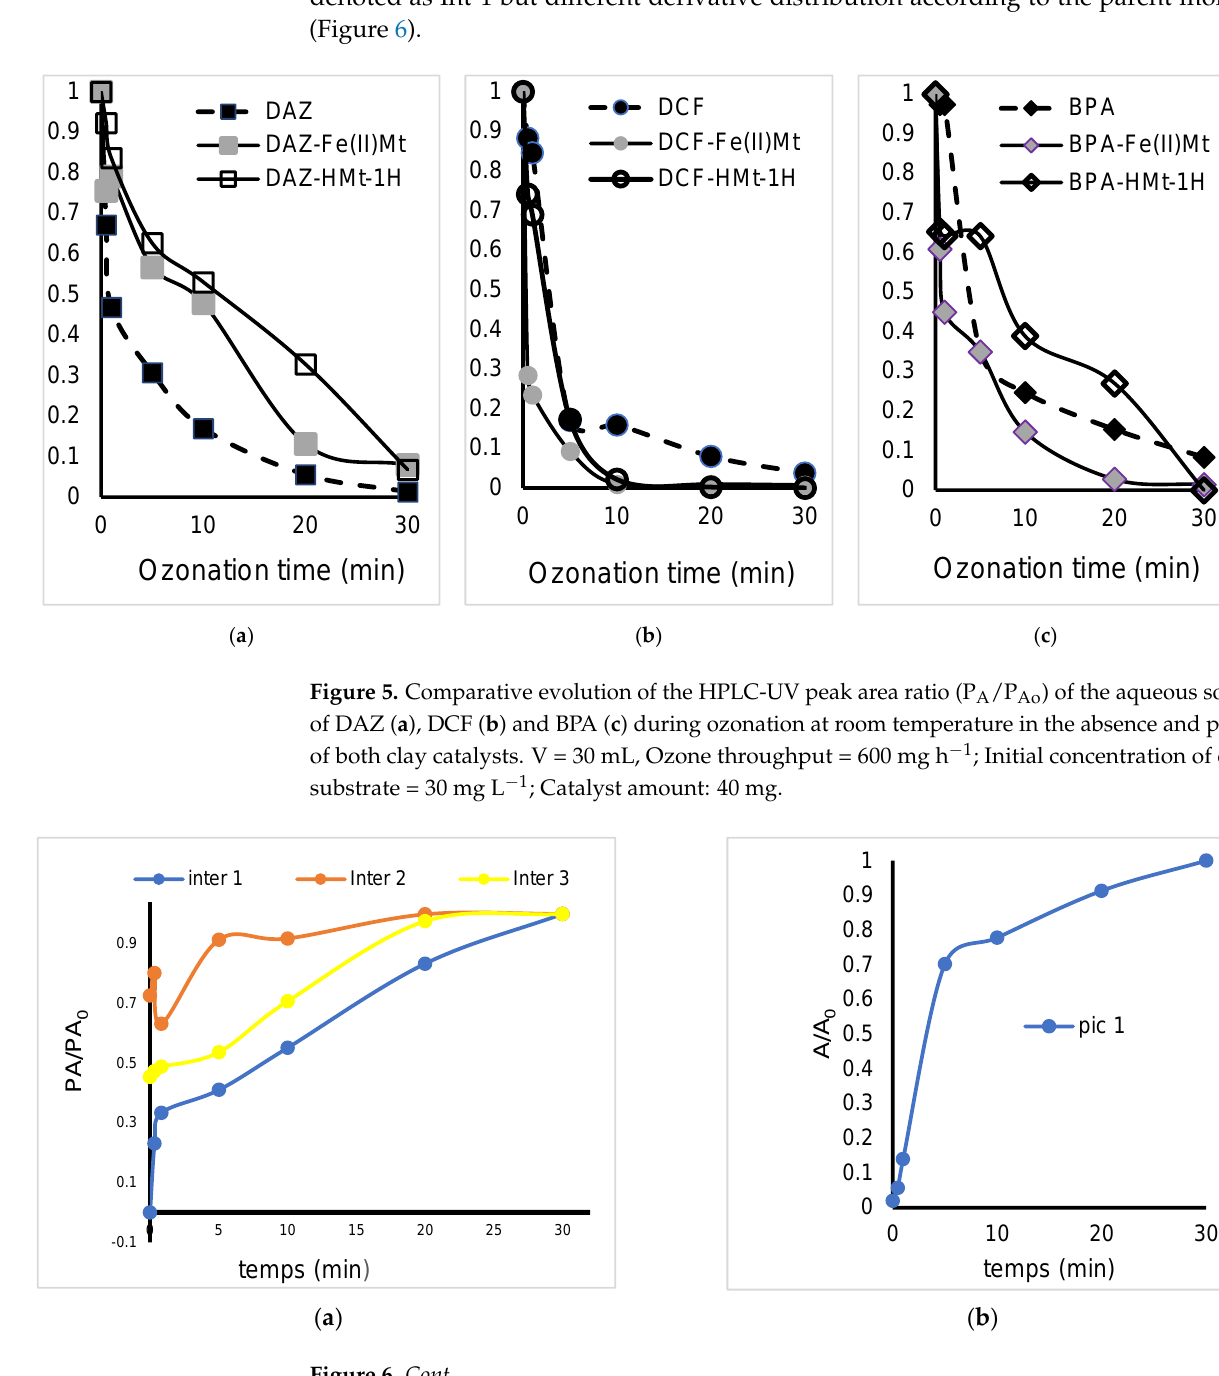
Figure 4. Evolution of UV-Vis spectra of the aqueous solutions of DAZ (a), DCF (b) and BPA (c) during non-catalytic ozonation at room temperature. V = 30 mL, Quartz cell length = 1 cm; Ozone throughput = 600 mg h −1 ; Initial concentration of organic substrate = 30 mg L −1 .